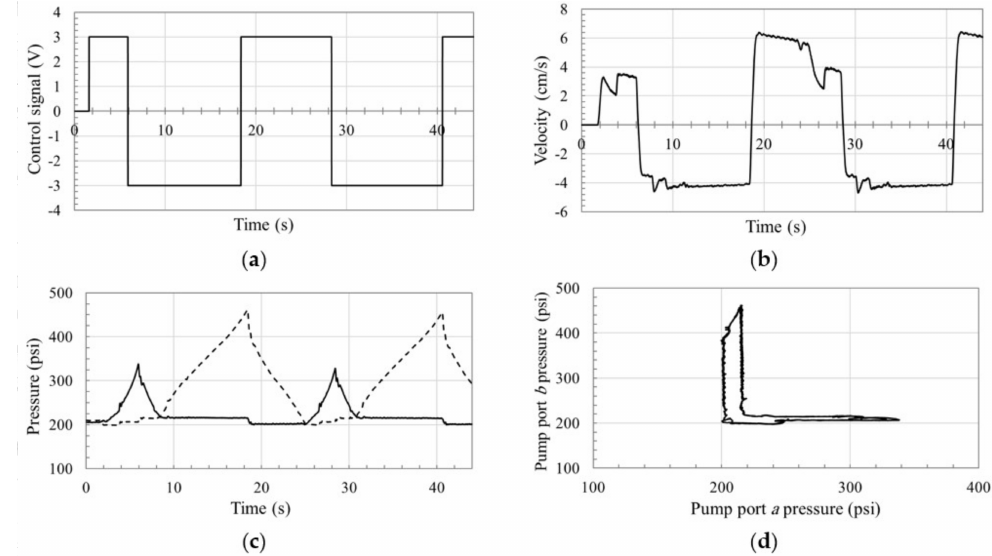
Figure 13. Performance of circuit using OC-SHV for a 41 kg attached mass: ( a ) control signal; ( b ) actuator velocity; ( c ) pressures at the pump ports a (solid line) and b (dotted line); ( d ) pump pressure plane.